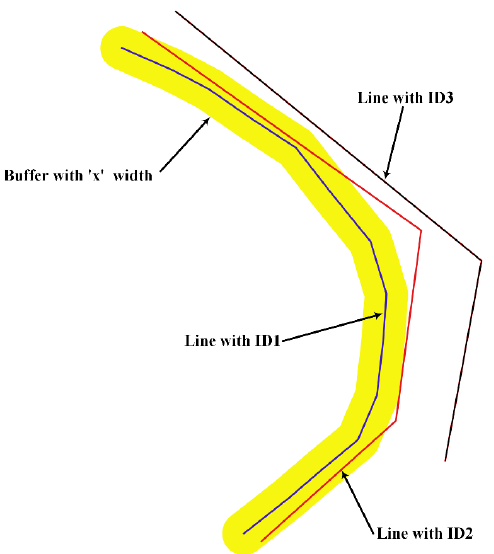
Figure 10. An example of the buffer method.